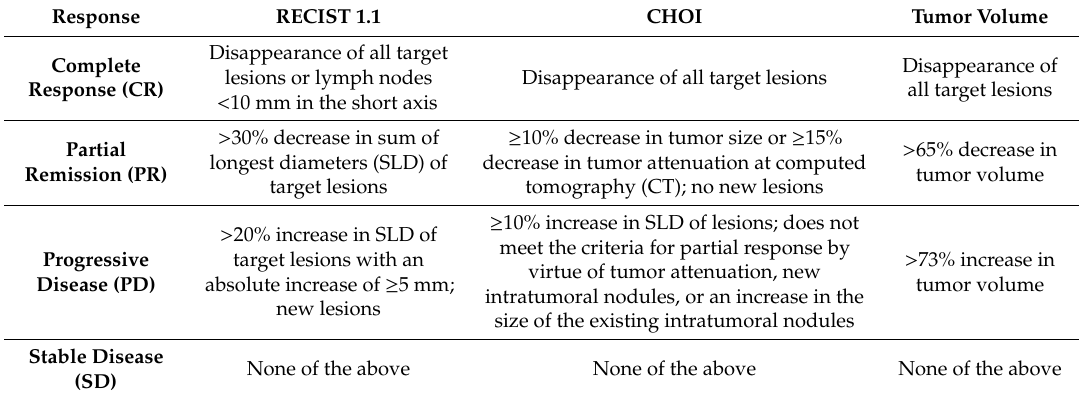
Table 4. Summary of response assessed by the RECIST 1.1, Choi and Tumor Volume